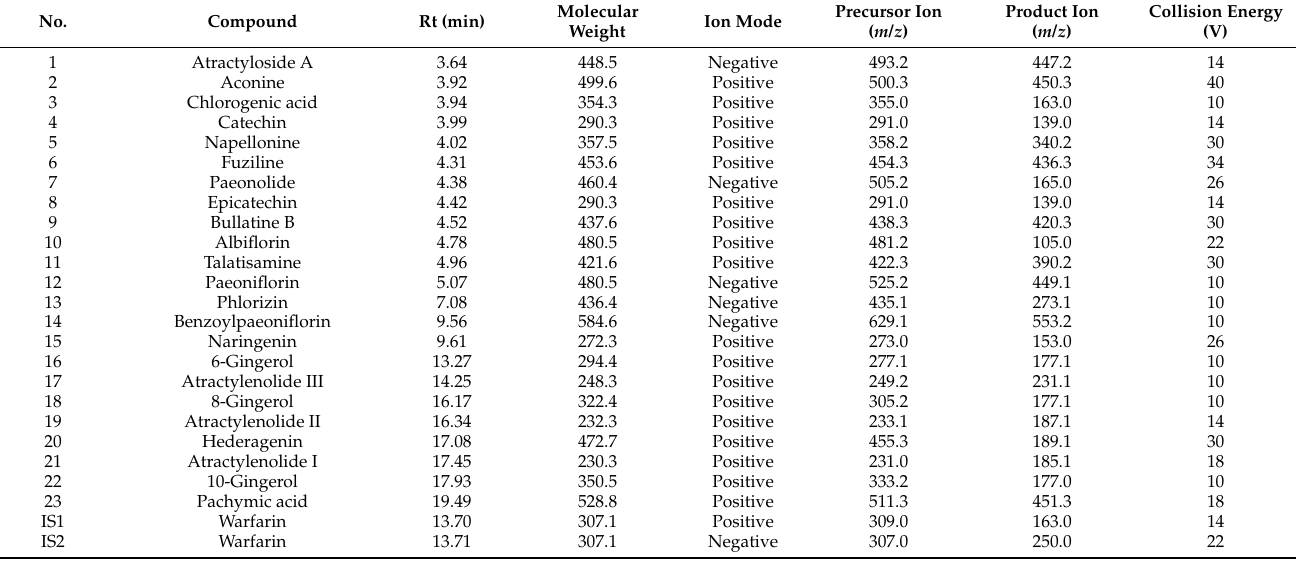
Table 7. MRM parameters of the 23 compounds and the internal